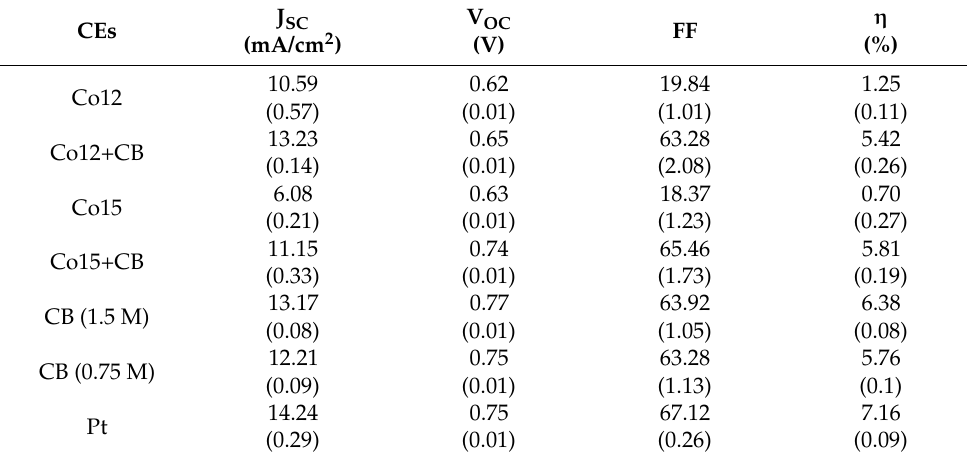
Table 2. Performance levels of DSSCs with cobalt derivatives mixed with CB as CEs. The values in the brackets are the standard deviation.